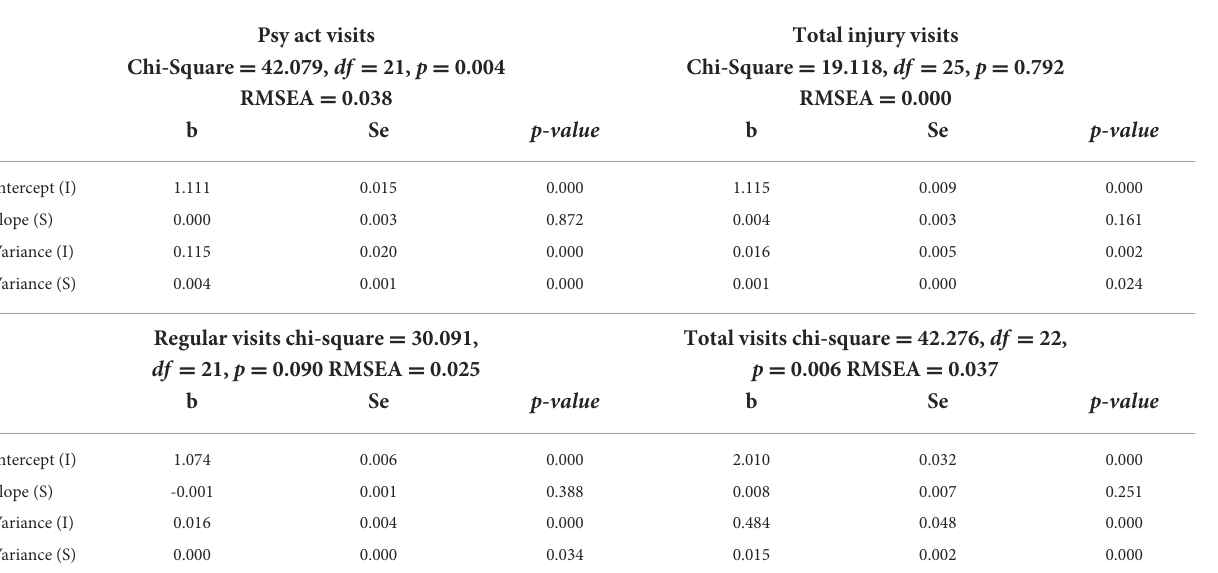
TABLE 3 LGM base models ( n =